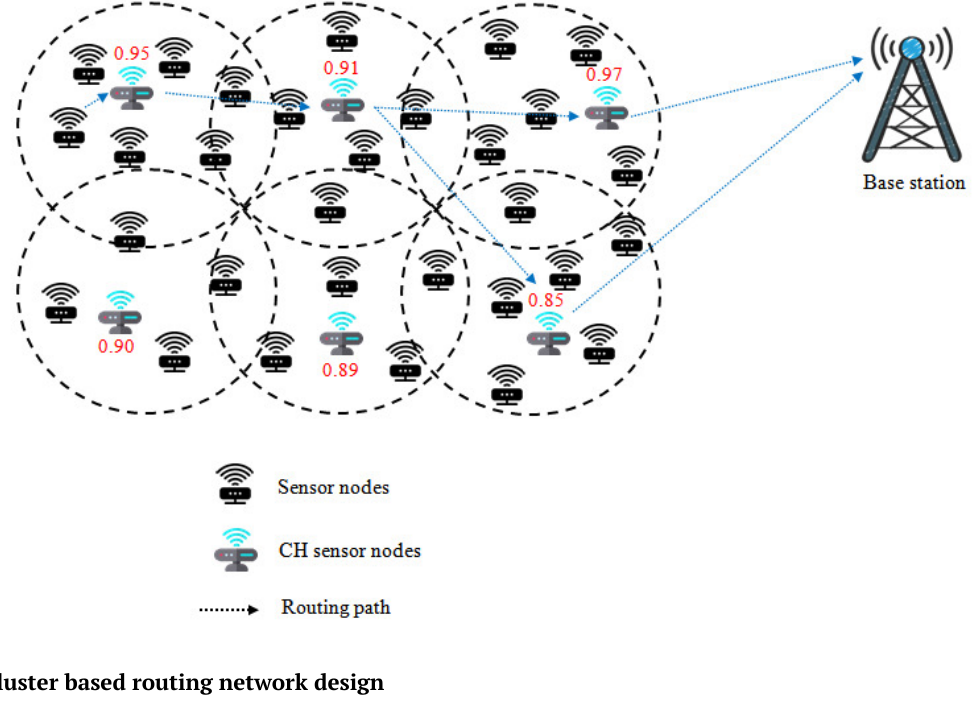
Figure 1. Cluster based routing network